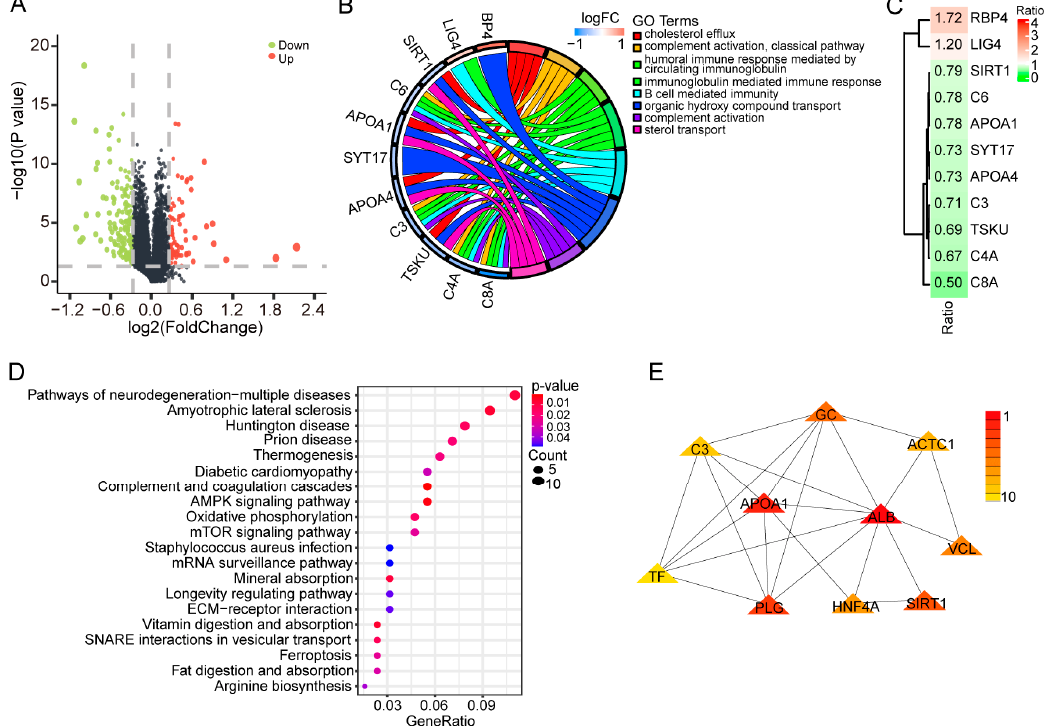
Figure 2. Proteomic analysis of PEDV-infected IPEC-J2 cells. ( A ) Volcano plot of differential expres- sion proteins between the PEDV-infected and uninfected groups. The red and green dots represent upregulated and downregulated proteins after PEDV infection, respectively. ( B ) Functional anno- tation for differentially expressed proteins. LogFC indicates the log2-transformed fold changes in protein expression between the PEDV-infected and uninfected groups. ( C ) Log2-transformed fold changes in the proteins involved in the functional terms. ( D ) Pathways significantly enriched by the differentially expressed proteins. ( E ) Core proteins identified by interactive analysis based on the STRING database. The coded color bar indicates the ranks of core